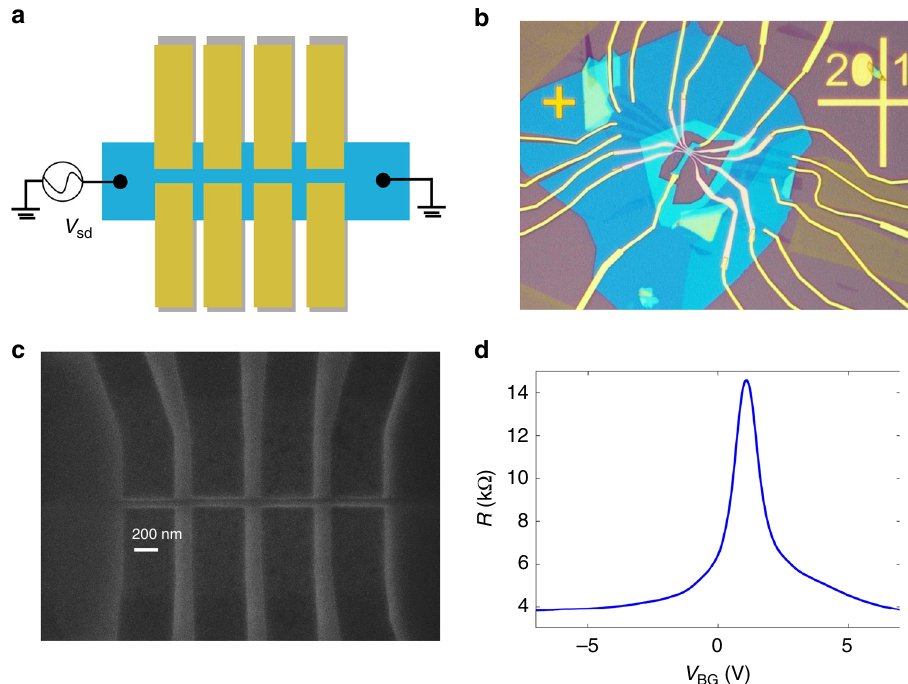
Fig. 2 Device characterization. a Device schematic and electrical measurement setup. b Optical image of complete device. c Exemplary scanning electron microscopy (SEM) image of bottom graphitic gates; scale bar is shown. d Back-gate dependence of BLG sample resistance.